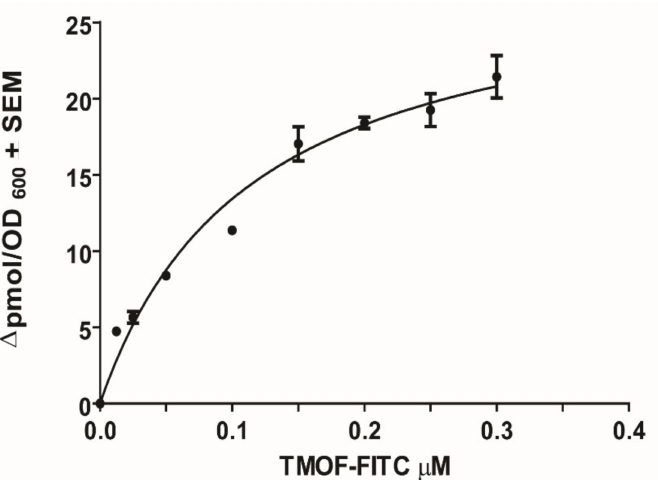
Figure 11. Specific binding of Aea TMOF-FITC to E. coli cells expressing AeaABC-TMOF receptor showing Michaelis Menten binding kinetics using a nonlinear regression (R 2 = 0.9526). Binding results were corrected for nonspecific binding (13%) to the bacterial cell wall. Each point is a mean of five determinations ± SEM. The data represent one experiment of three independent experiments with similar results. K D = 113.7 ± 18 nM ± SEM, B max = 28.7 ± 1.8 pmo/OD 600 ± SEM and K assoc = 8.8 × 10 6 M − 1